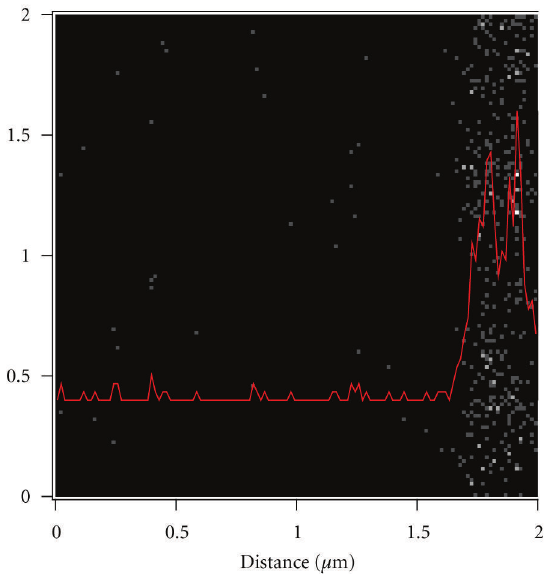
Figure 10: Indium positive secondary ion image from BAM L200 (same data set as Figure 9). The unresolved indium features actually consist of two line pairs (each with 5nm wide indium rich lines)— the distance between the line pairs is not documented.